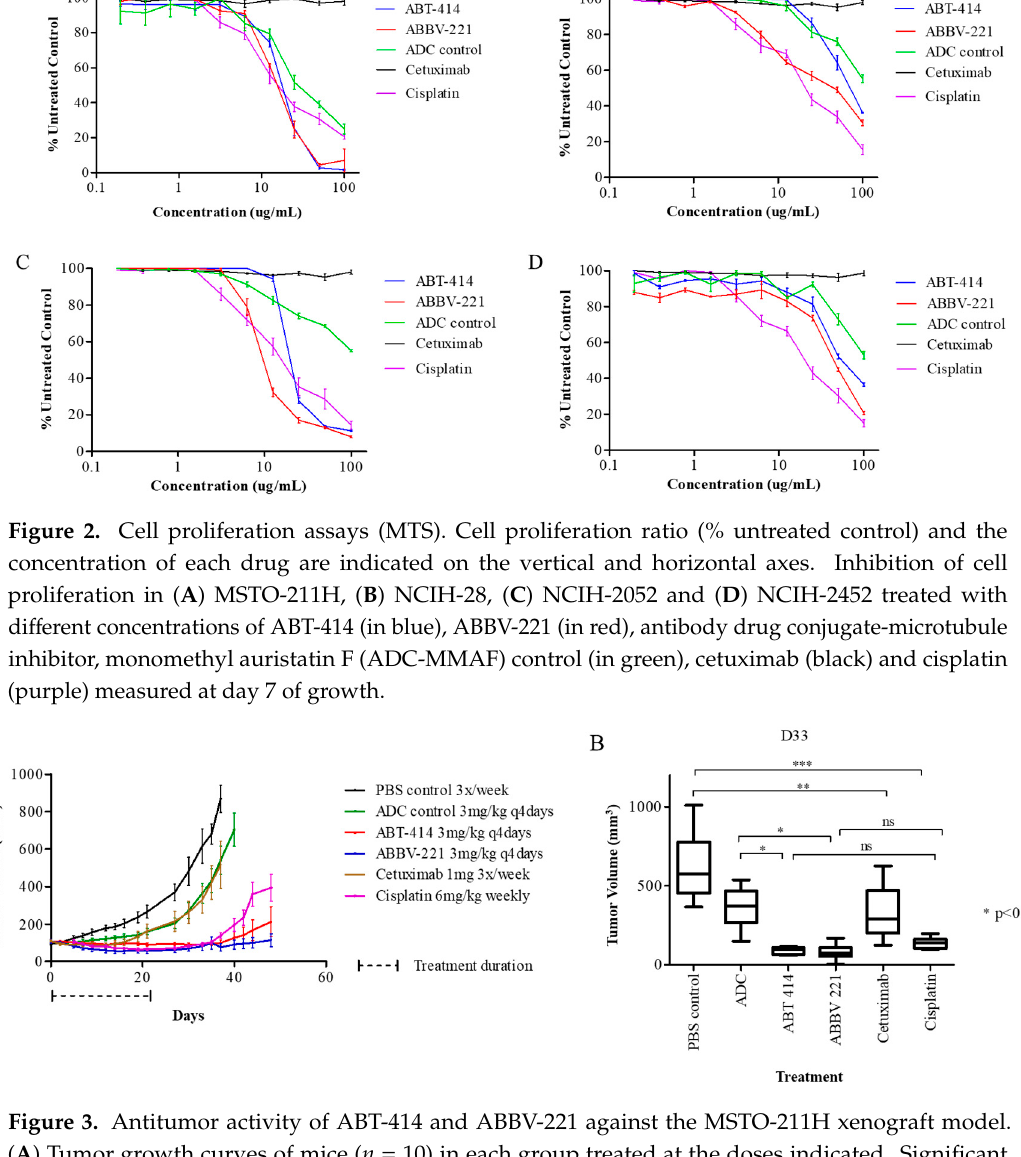
Figure 2. Cell proliferation assays (MTS). Cell proliferation ratio (% untreated control) and the concentration of each drug are indicated on the vertical and horizontal axes. Inhibition of cell proliferation in ( A ) MSTO-211H, ( B ) NCIH-28, ( C ) NCIH-2052 and ( D ) NCIH-2452 treated with different concentrations of ABT-414 (in blue), ABBV-221 (in red), antibody drug conjugate- microtubule inhibitor, monomethyl auristatin F (ADC-MMAF) control (in green), cetuximab (black) and cisplatin (purple) measured at day 7 of growth.